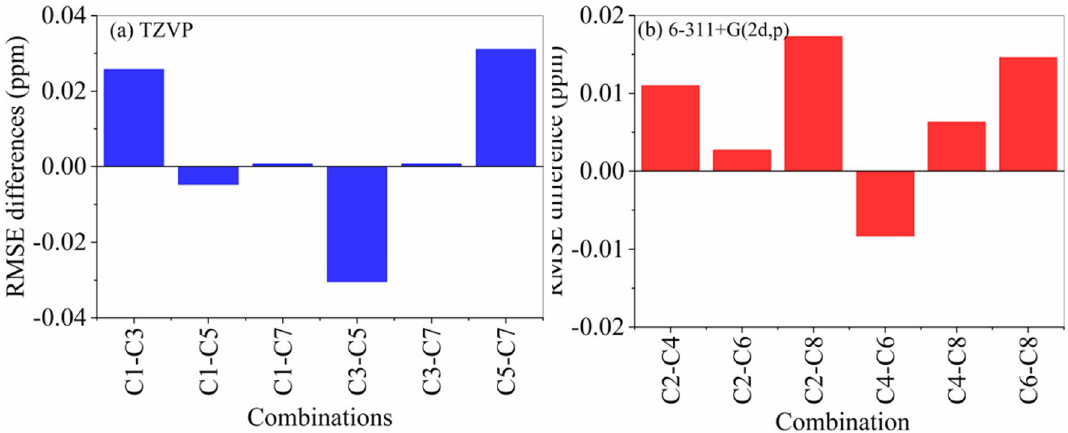
Figure 4. Graphical representation of the average difference of RMSE values (in ppm) between each pair of the eight combinations ( a ) TZVP and ( b ) 6–311 + G(2d,p). C1-C8 belong to the combination numbers from